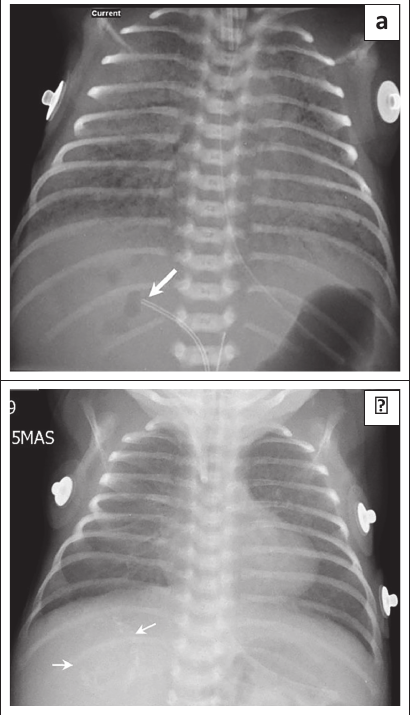
FIGURE 4: (a) Umbilical venous catheter (UVC) (arrow) incorrectly positined within the right branch of the portal vein. Motted gas shadows within the liver represent complicatins related to UVC infusate delivered into liver. This could represent liver parenchymal injury and/or liver abscess formatin. It should be diffrentited from bubbles of air that can be seen within the portal vein soon aftr catheris. (b) Follow- up CXR of patint in image 4a. CXR done one month later shows rim calcifid lesion (arrows) within the liver. The infusate within the liver has become encysted and, together with hepati necrosis, has formed the calcifid